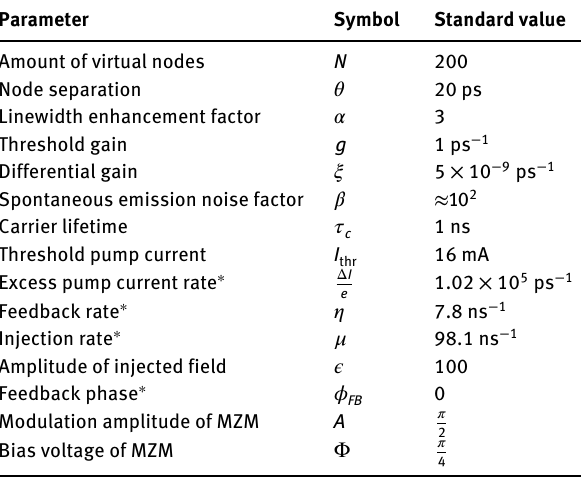
Table 1: Parameters, together with their respective values, used in the simulations. Parameters marked with ∗ can be different from given values, when